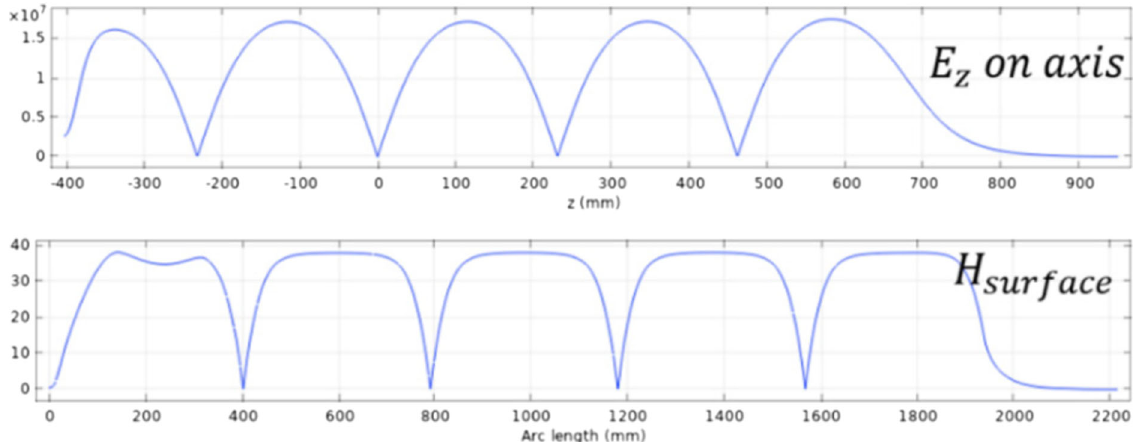
FIG. 8. Axial electric and surface magnetic field for the five-cell cavity at 10 MV voltage gain.